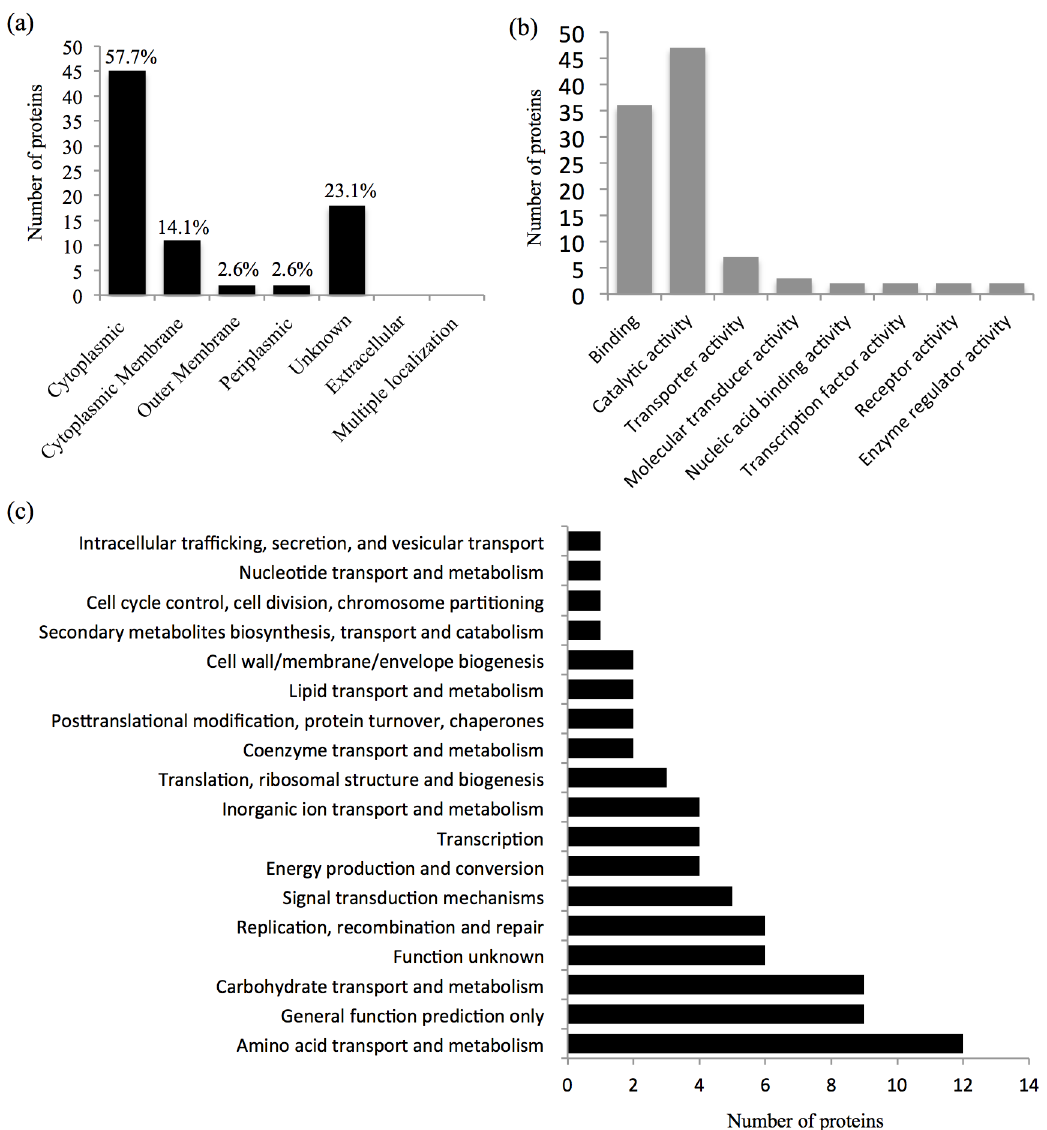
Fig 3. Distribution of identified phosphoproteins. (a) cellular localization, (b) molecular function in gene otology, and (c) cluster of orthologous